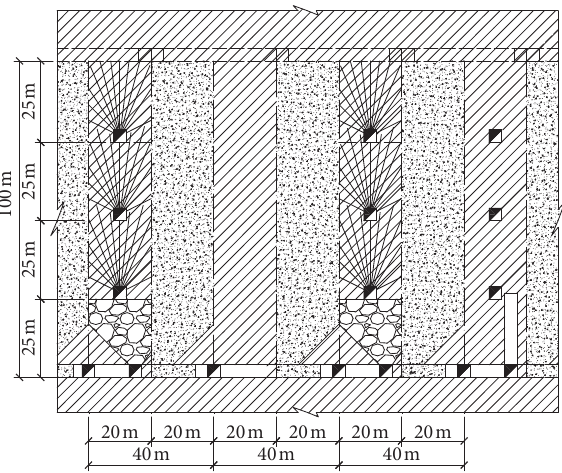
Figure 1: The open-stope and backfill mining Table 1: Conventional experiment results of the specimens.